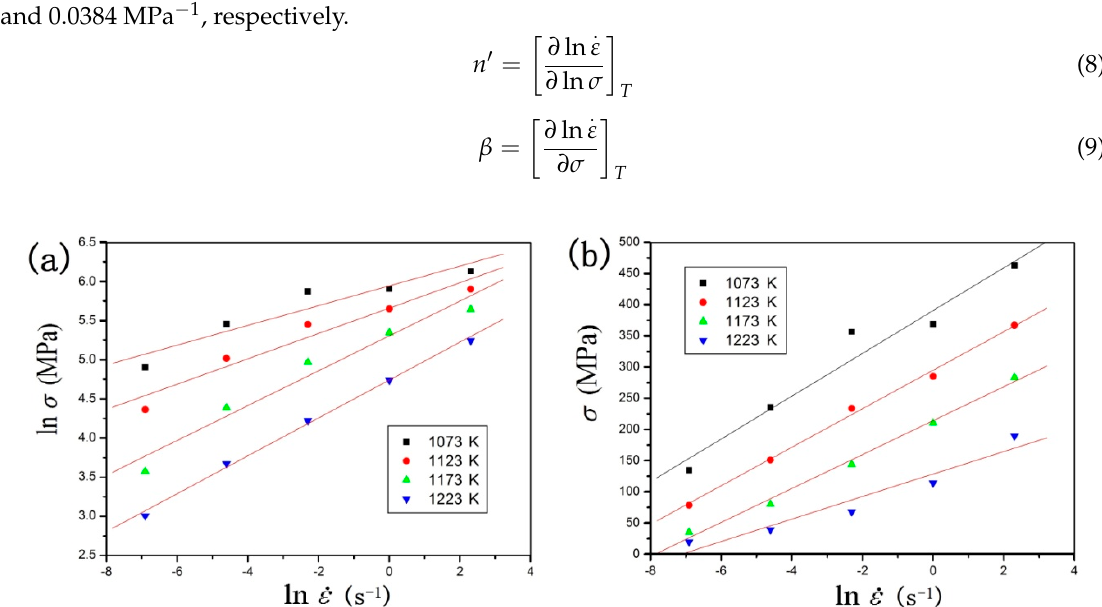
Figure 5. Evaluating the value of ( a ) n’ by plotting ln σ versus ln έ and ( b ) β by plotting σ versus ln έ .